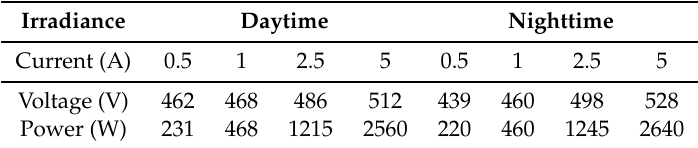
Table 2. Behaviour of PV panels under different conditions during direct polarisation: Daytime (800 W/m 2 ), Night-time (1 W/m 2 ).